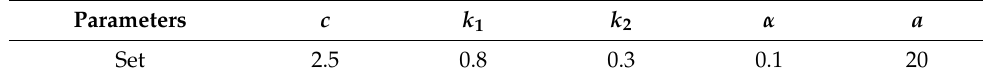
Table 1. Initial parameters of the optimization model.